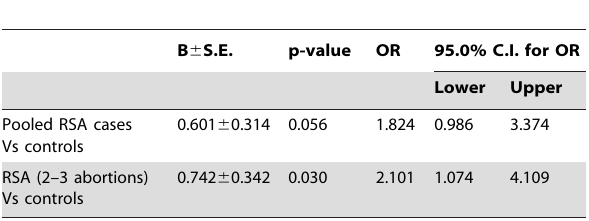
Table 2. Odds ratio for the *2 allele in RSA pooled samples and in the 2–3